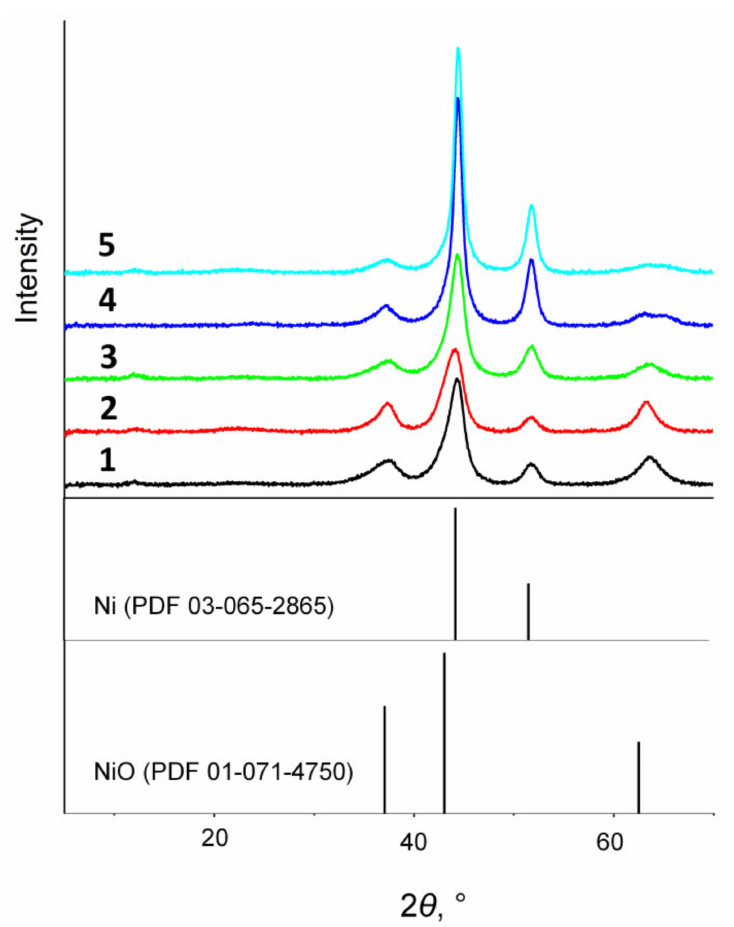
Figure 4. Diffraction patterns of the Ni@NiAlO x samples with different Ni/Al atomic ratio and ob- tained at different reduction temperatures (holding at the reduction temperature for 2 h): Ni@NiAlO x - 2-500 (line 1), Ni@NiAlO x -3-500 (line 2), Ni@NiAlO x -4-500 (line 3), Ni@NiAlO x -3-600 (line